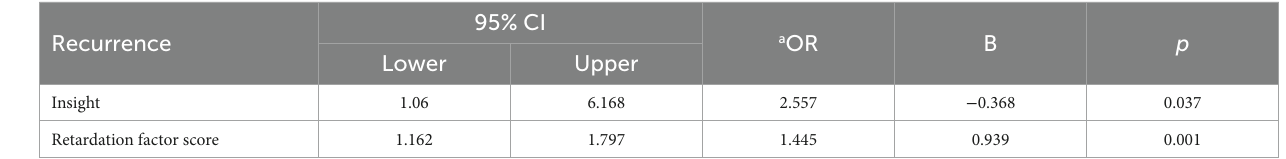
TABLE 3 Binary logistic regression model to predict